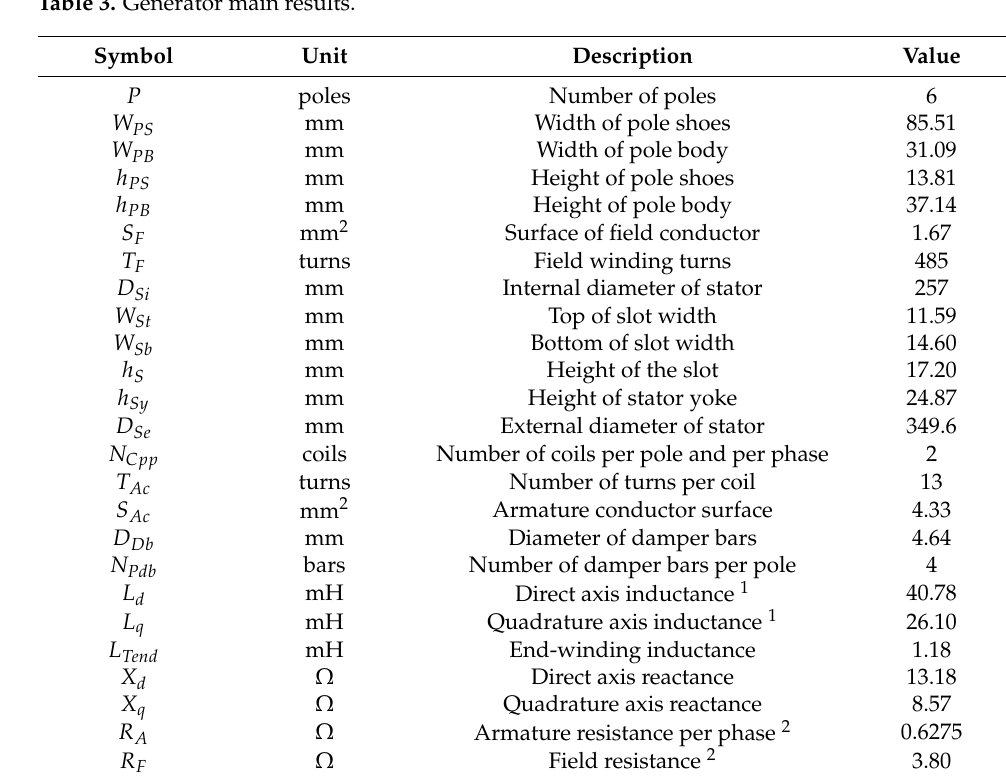
Figure 7. Inductance L 2 ps obtained by finite element simulation. Table 3. Generator main